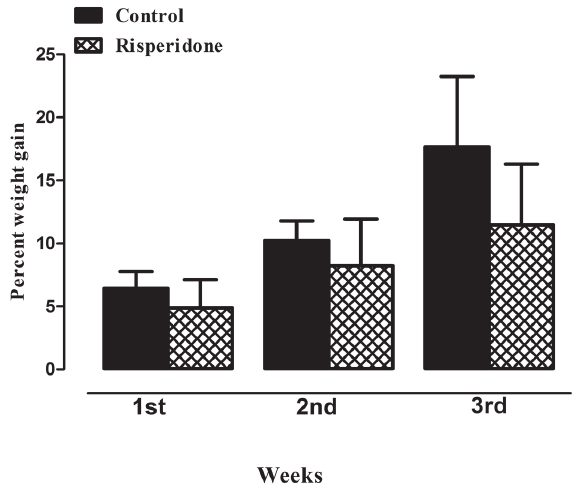
FIGURE 1 - Effect of risperidone on percent weight gain: Three weeks treatment of rats treated with risperidone (2.5 mg/kg/d) orally showing no significant rise in percent weight (ANOVA followed by Bonferroni’s Multiple Comparison Test, not significant).